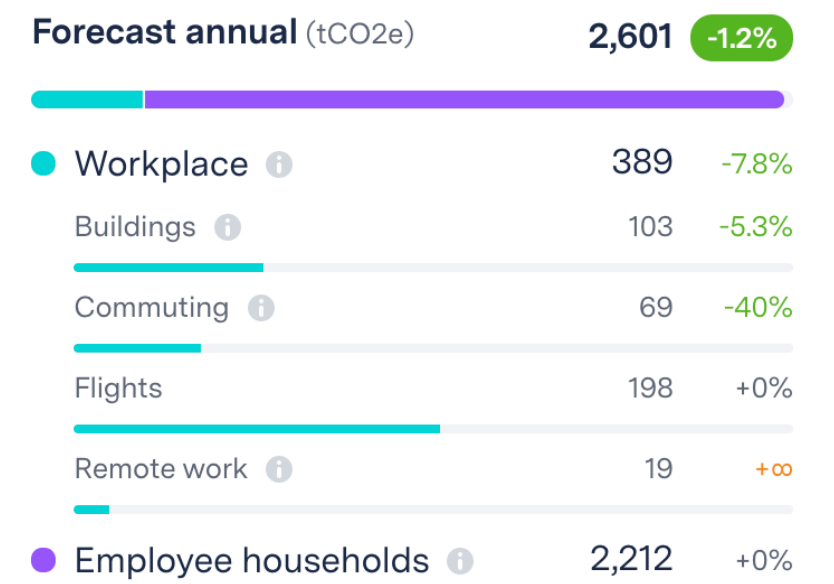
Figure 1. Forecast—3 days at the office, accessed on 9 September 2021.